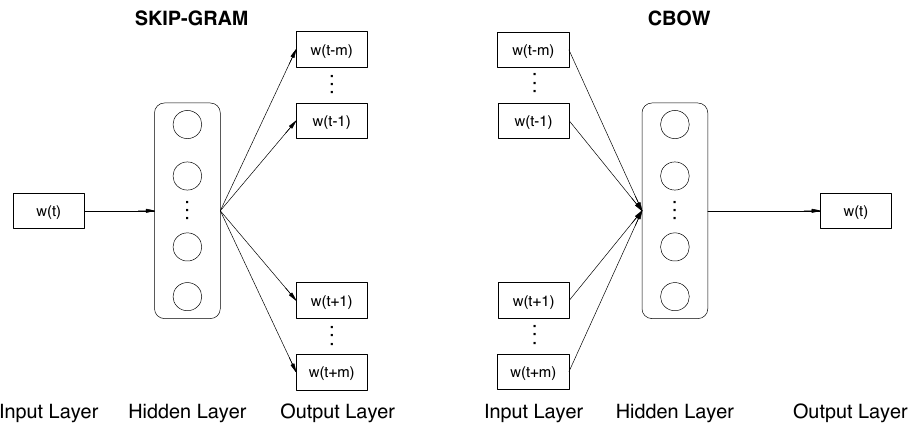
Figure 2. A schematic view of the neural networks in the Word2Vec